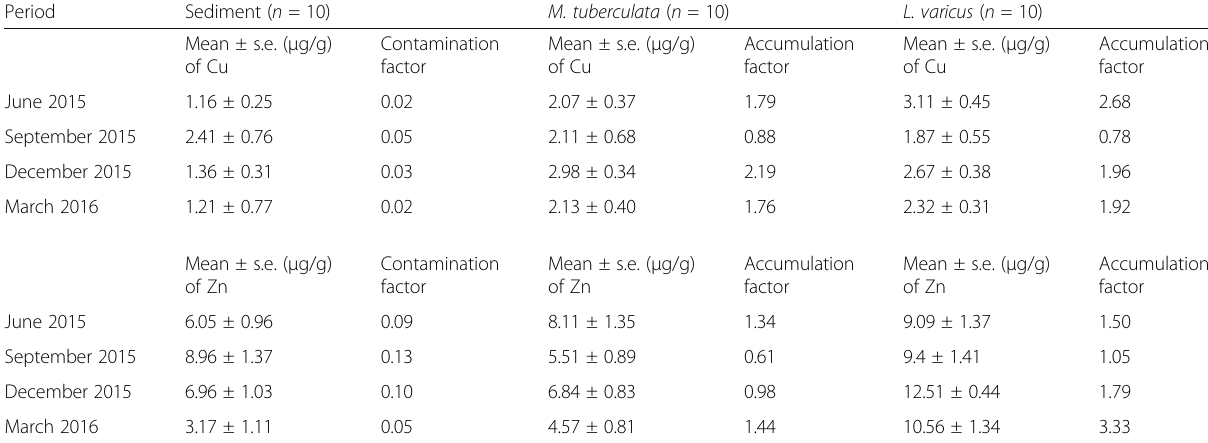
Table 1 Concentrations of Cu and Zn in the benthic sediment and two dominant gastropod species of River Osun and their accumulation factors